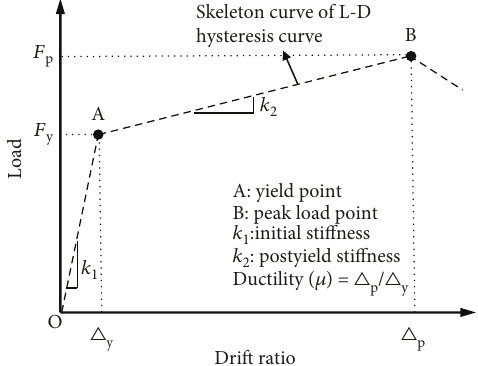
Figure 7: Schematic diagram of characteristic values of L-D hysteresis